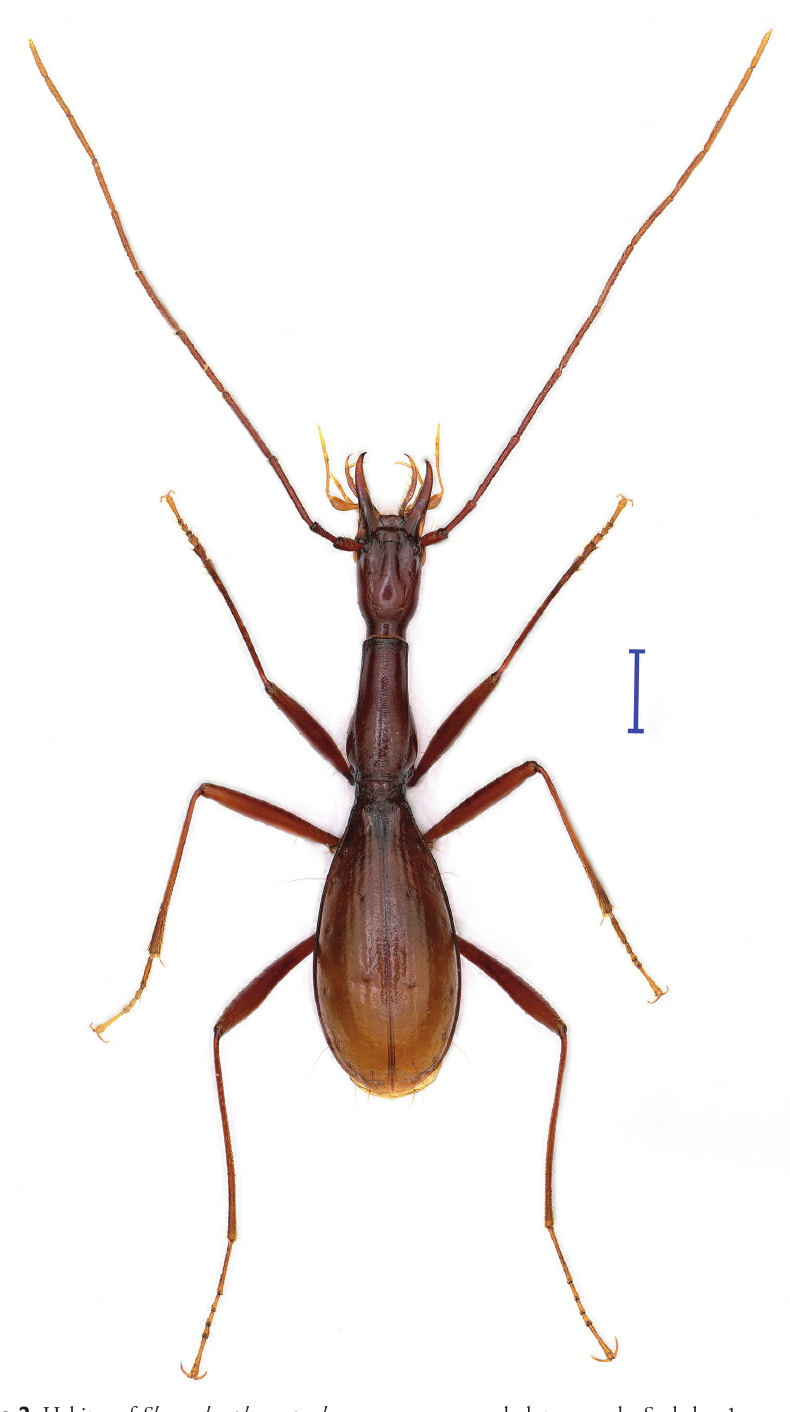
Figure 2. Habitus of Shuangheaphaenops elegans gen. n., sp. n., holotype, male. Scale bar 1